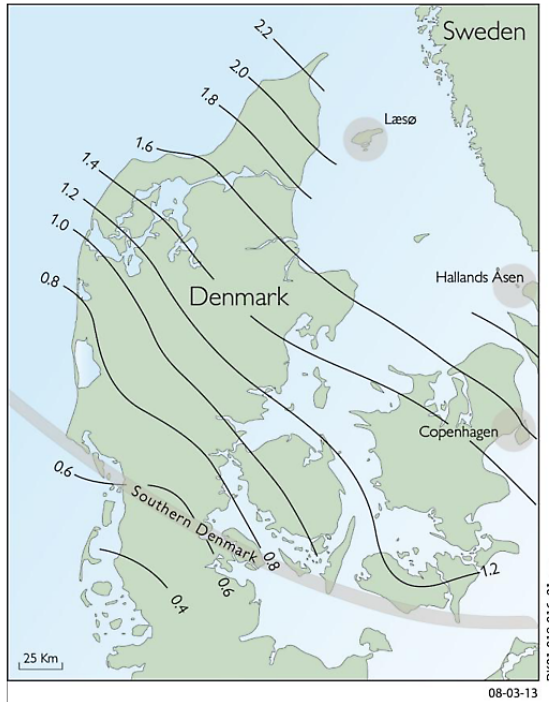
Fig. 3. Modern geodetic map (from Knudsen et al., 2012) with post- glacial uplift in millimetres per year, based on GPS, levelling and sea level stations. Four treated claims of earthquakes or other irreg- ularities are shown by grey